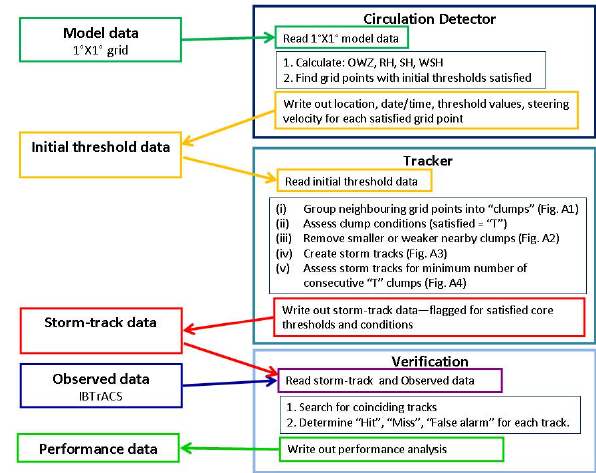
Fig. 3. Schematic representation of the detection, tracking and ver- ification procedures used in the OWZP detection system. The five steps in the Tracker box are further illustrated in Figs.